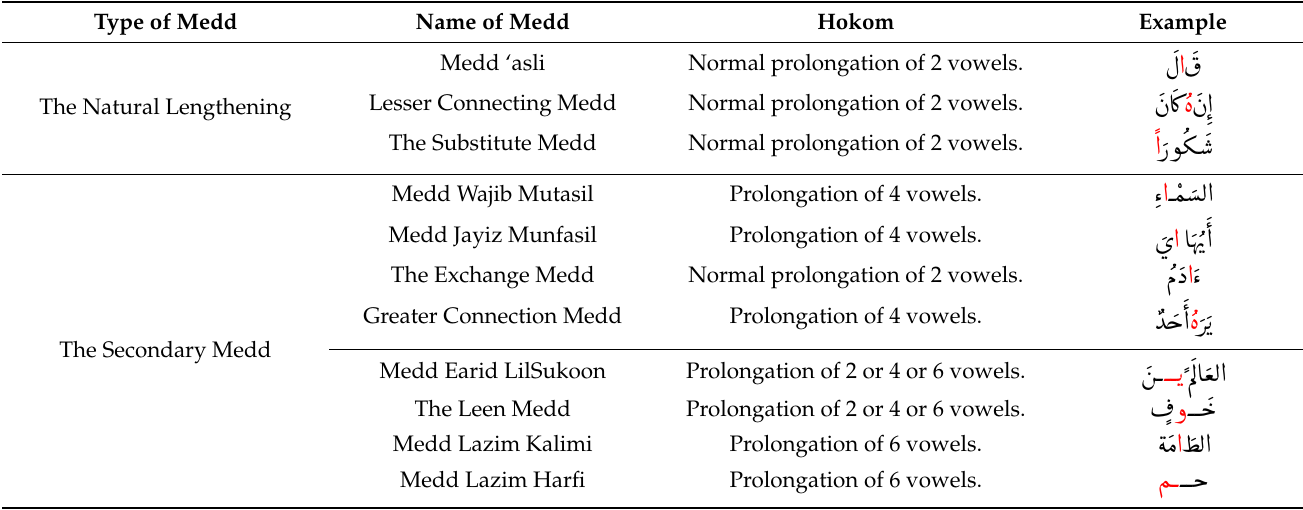
Table 1. Types of